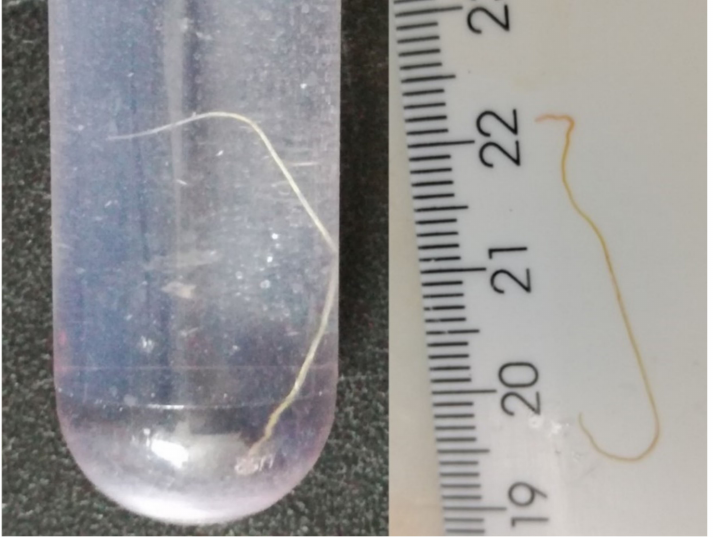
Figure 8. Wapiti, case 2. The nematodes from the meningeal vessels were confirmed by molecular methods as Elaphostrongylus cervi